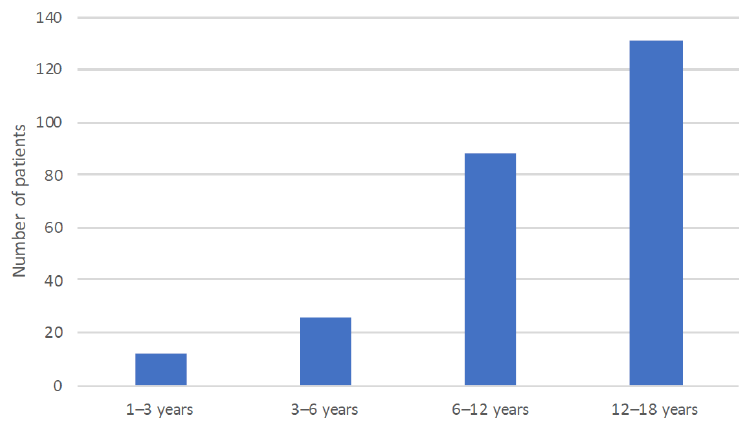
Figure 1. Age distribution of pediatric vertigo and dizziness. In 182 (70.8%) children, there was no nystagmus visible with video Frenzel goggles; in 40 (15.6%), there was no data, and in 35 (13.6%), the nystagmus was detected. In 17